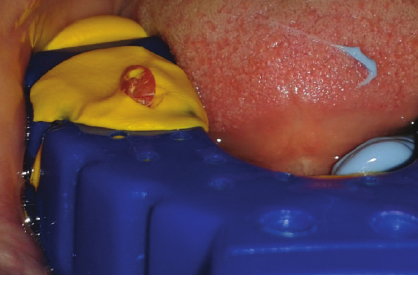
Figure 16: Coping screw exposed.